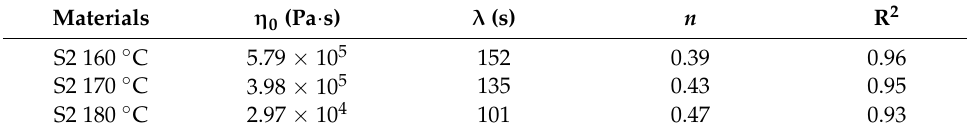
Table 3. Fitting parameters of the Carreau model for S2 under various temperatures.